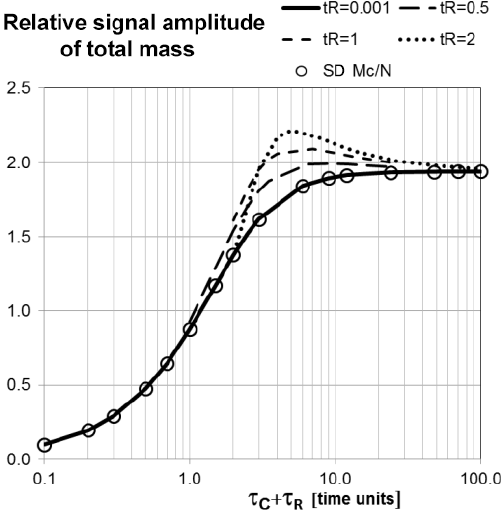
Figure 4. Signal amplitudes in standard deviations for river runoff normalized by recharge: σ RR /σ N versus total mass time constant τ T = τ C + τ R for combinations in ( τ C , τ R